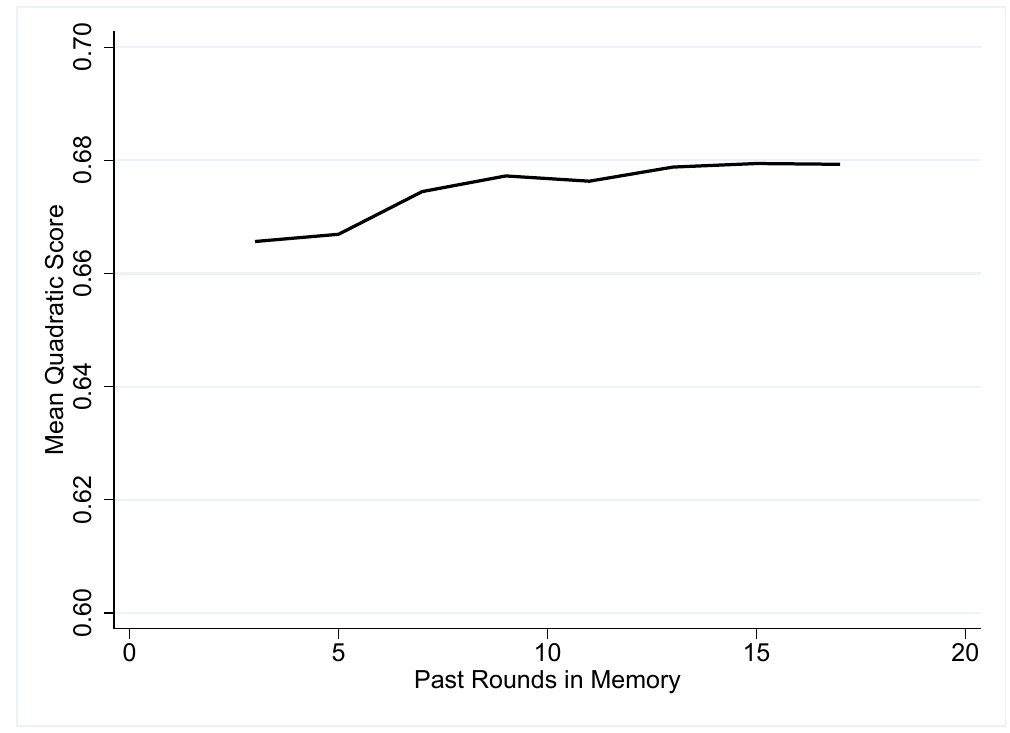
Figure 4. Length of Memory M